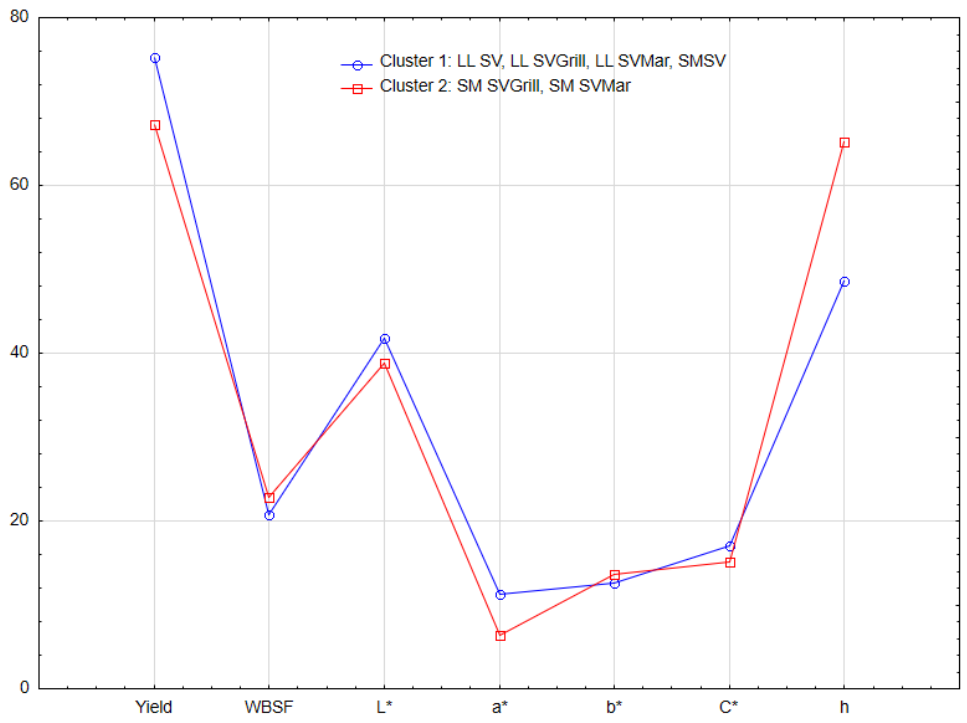
Figure 4. Cluster analysis of semimembranosus (SM) and longissimus lumborum (LL) muscles subjected to sous vide (SV), sous vide and grilling (SVGrill), and marinating and sous vide (SVMar).